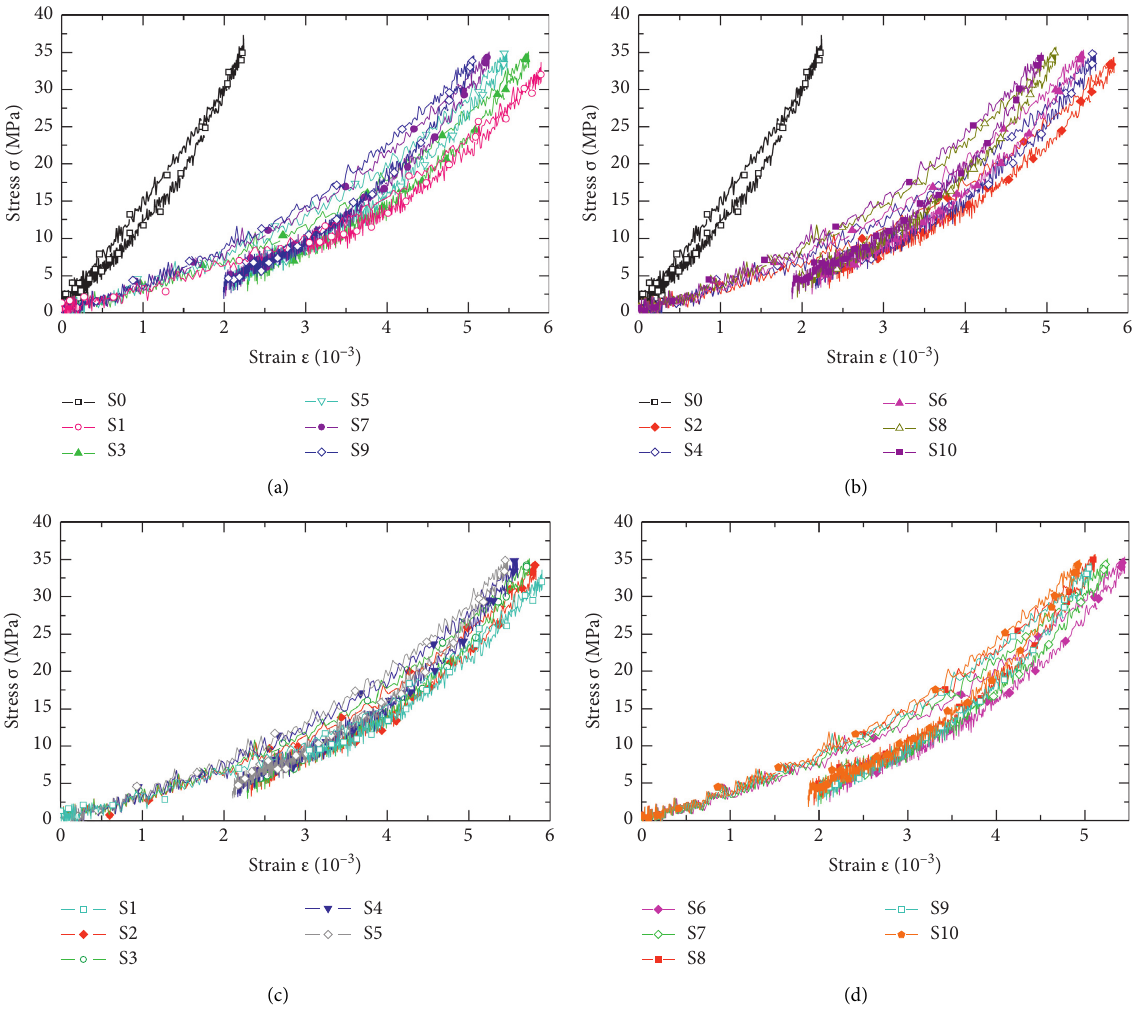
Figure 8: The stress-strain curves of specimens. (a) An intact specimen S0 and jointed specimens (S1, S3, S5, S7, S9); (b) an intact specimen S0 and jointed specimens (S2, S4, S6, S8, S10); (c) jointed specimens (S1, S2, S3, S4, S5); (d) jointed specimens (S6, S7, S8, S9,